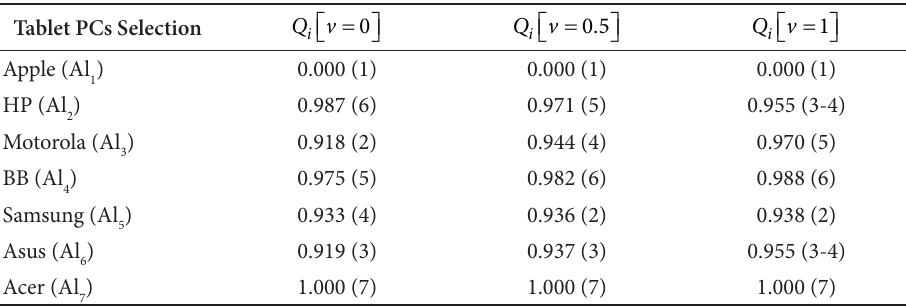
Table 6. The preference order ranking by VIKOR for sensitivity analysis Tablet PCs